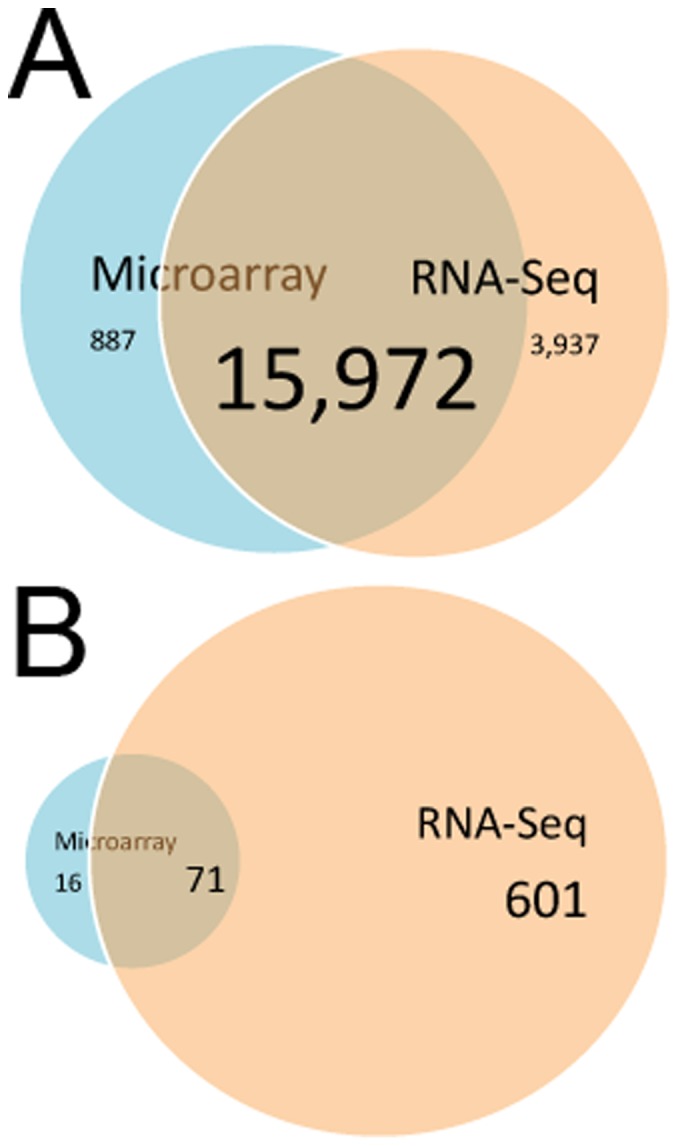
Comparison of Microarray and RNA-seq platforms.To compare data from the Microarray and RNA-Seq platforms, data from Genesprings (microarray) and DuffDiff (RNA-seq) were imported into Ingenuity Pathway Analysis Software. (A) Comparison of total gene expression in microarray and RNA-seq. For the microarray, the number of genes present after filtering for probe intensity between the 20th and 100th percentiles is shown in blue. The total number of reads aligned to the reference genome (FPKM>0) from the RNA-seq experiment is shown in pink. Most of the genes that are expressed overlap in both platforms; however, RNA-seq detected an overall larger number of expressed genes relative to the microarray (B) Comparison of regulated genes in microarray and RNA-seq experiments. All of the genes that were regulated up or down 2-fold, p<0.05 in the microarray are shown in blue. Genes that were determined to be regulated up or down 2-fold, q <0.05 in the RNA-seq experiment are shown in pink.